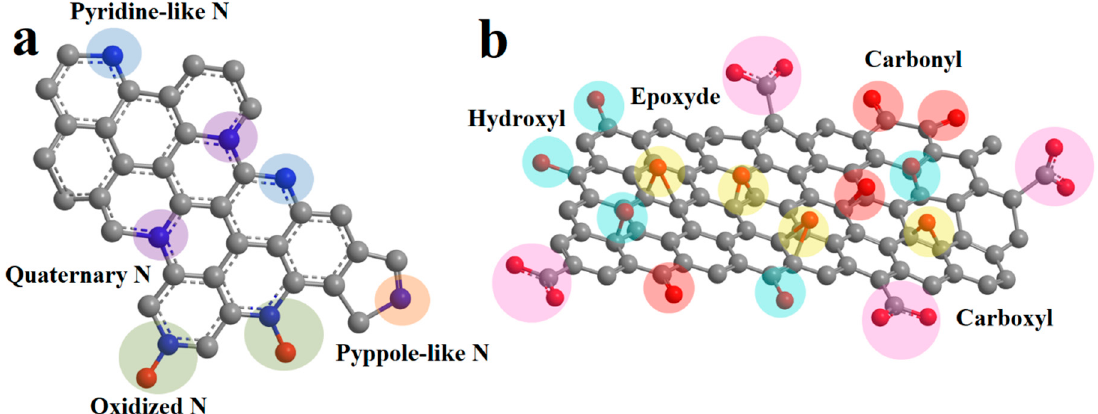
Figure 1. Schematic presentation of nitrogen atoms ( a ) and oxygen ( b ) on the surface of graphene sheets [28,29].